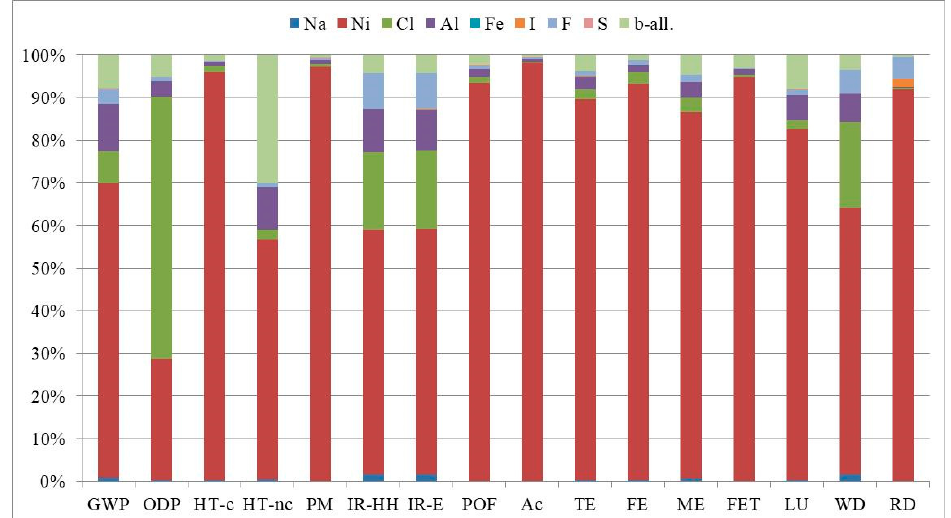
Figure 3. Environmental impacts of the tubular cell: dominance analysis (percentage incidence).